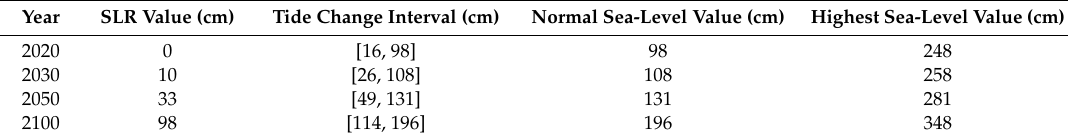
Table 4. Sea-level simulation results.